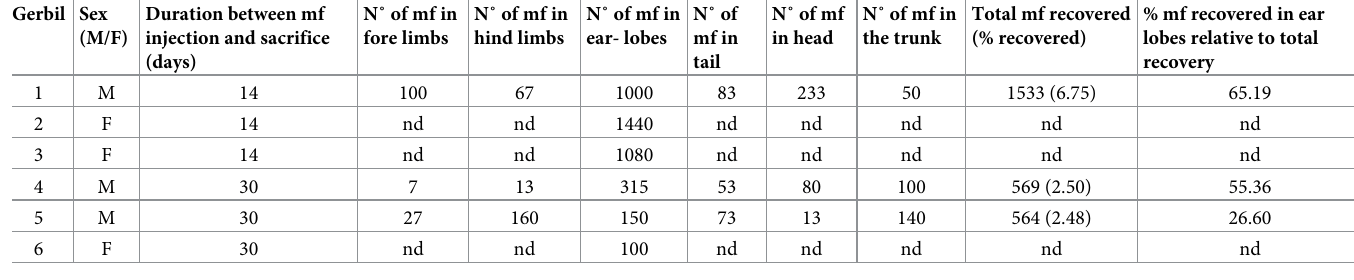
Table 1. Susceptibility of gerbils to O . ochengi mf. Each gerbil was subcutaneously infected at the nape with 22,725 O . ochengi mf. Gerbils were analyzed 14 or 30 days post-infection for O . ochengi mf in the ear lobes alone, or including the skin of other parts. Gerbil Sex Duration between mf N˚ of mf in (M/F) injection and sacrifice fore (days)